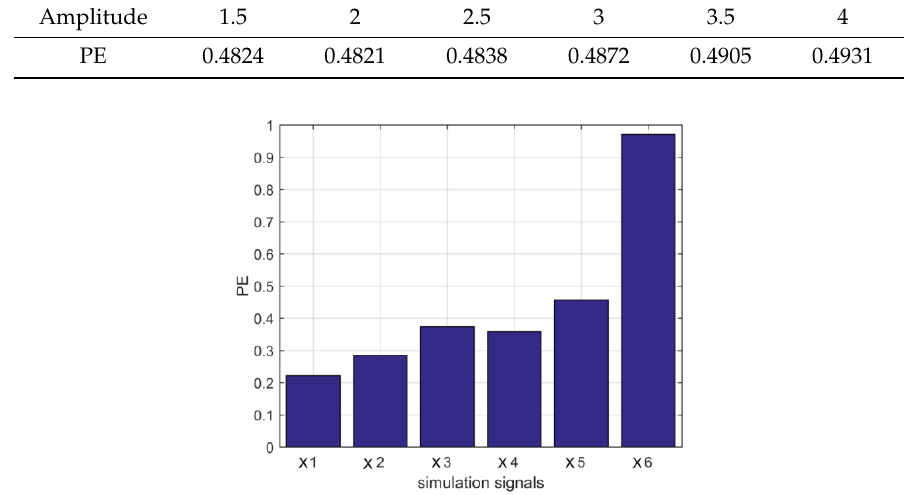
Figure 1. The permutation entropy value of each simulation signal.